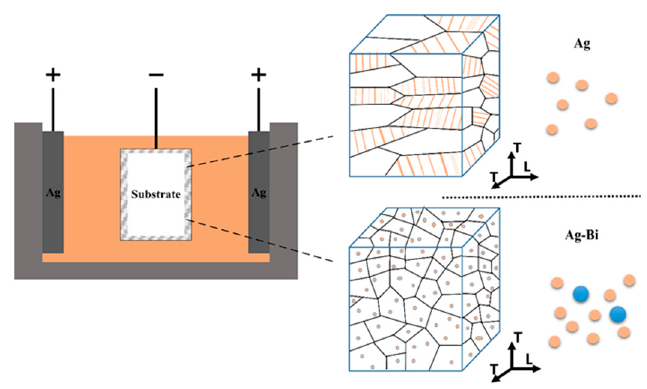
Figure 9. The sketch of Bi addition on the microstructure of the nanocrystalline Ag coating in the the electrodeposition process.